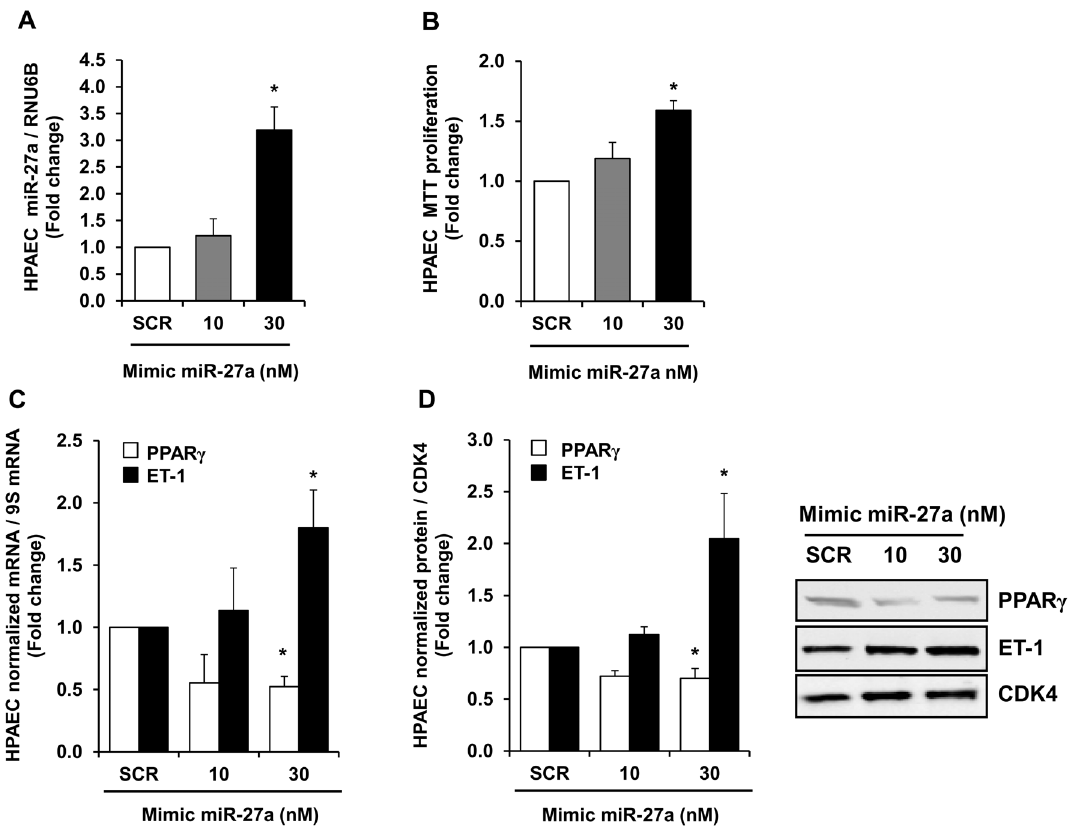
Figure 3. Overexpression of miR-27a with a miR-27a mimic increased miR-27a levels, HPAEC proliferation, and ET-1 levels and reduced PPAR c levels. HPAECs were exposed to normoxia (NOR) for 72 h and treated with graded concentrations of miR-27a mimic. qRT-PCR was employed to detect alterations in miR-27a, PPAR c , and ET-1 levels. Western blotting was employed to detect PPAR c and ET-1 protein levels. HPAEC proliferation was determined using MTT assays. Each bar represents the mean 6 SE miR-27a ( A ), proliferation ( B ), or PPAR c or ET-1 mRNA relative to ribosomal S9 (9S RNA) ( C ), or PPAR c or ET-1 protein relative to CDK4 protein ( D ) expressed as fold-change vs. control. *p , 0.05 vs. scrambled (SCR) miR mimic, n=3–5.